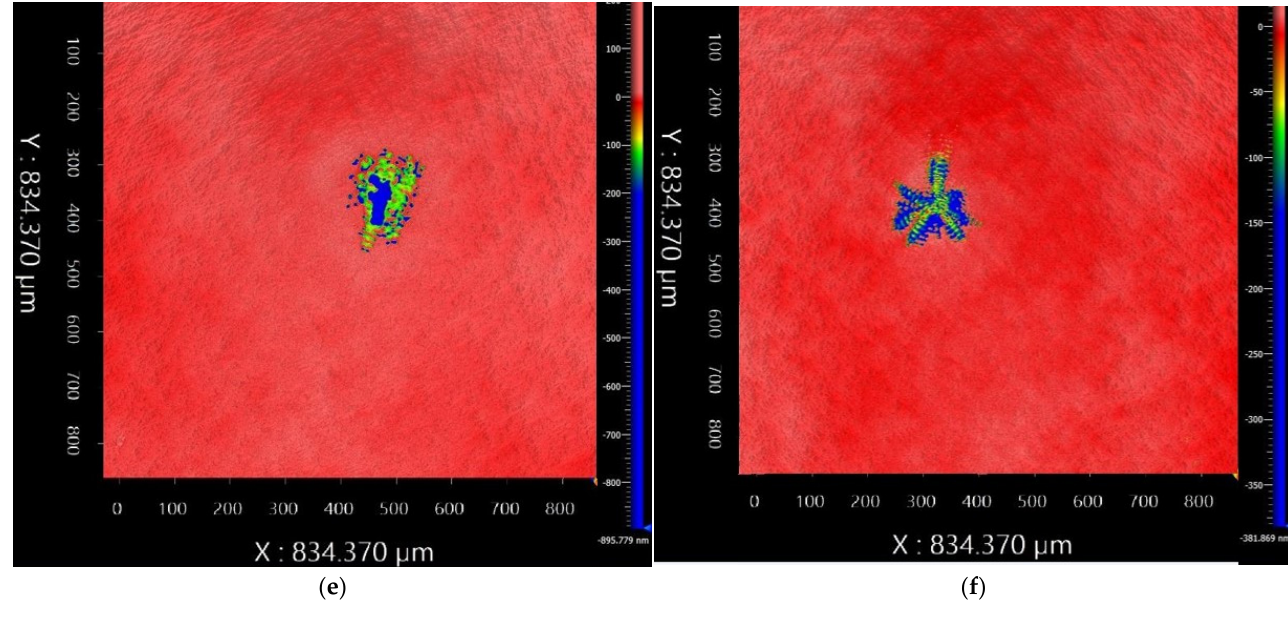
Figure 9. Typical three-dimensional damage patterns of laser protection films: TiO 2 /SiO 2 film at ( a ) 1064 nm, 5.99 J/cm 2 and ( b ) 532 nm, 3.04 J/cm 2 ; HfO 2 /SiO 2 film at ( c ) 1064 nm, 5.89 J/cm 2 and ( d ) 532 nm, 1.48 J/cm 2 ; Ta 2 O 5 /SiO 2 film at ( e ) 1064 nm, 9.99 J/cm 2 and ( f ) 532 nm, 4.93 J/cm 2 .